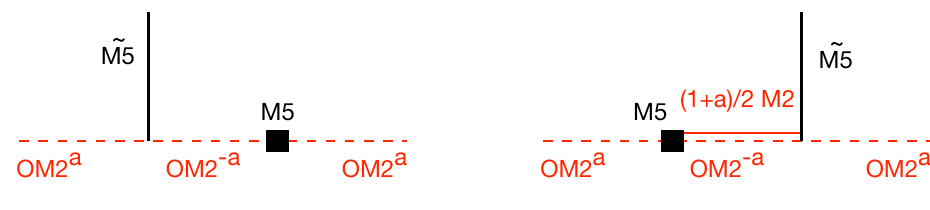
Figure 9 . Creation or not of an M2-brane when M5-branes cross on an OM2-plane.